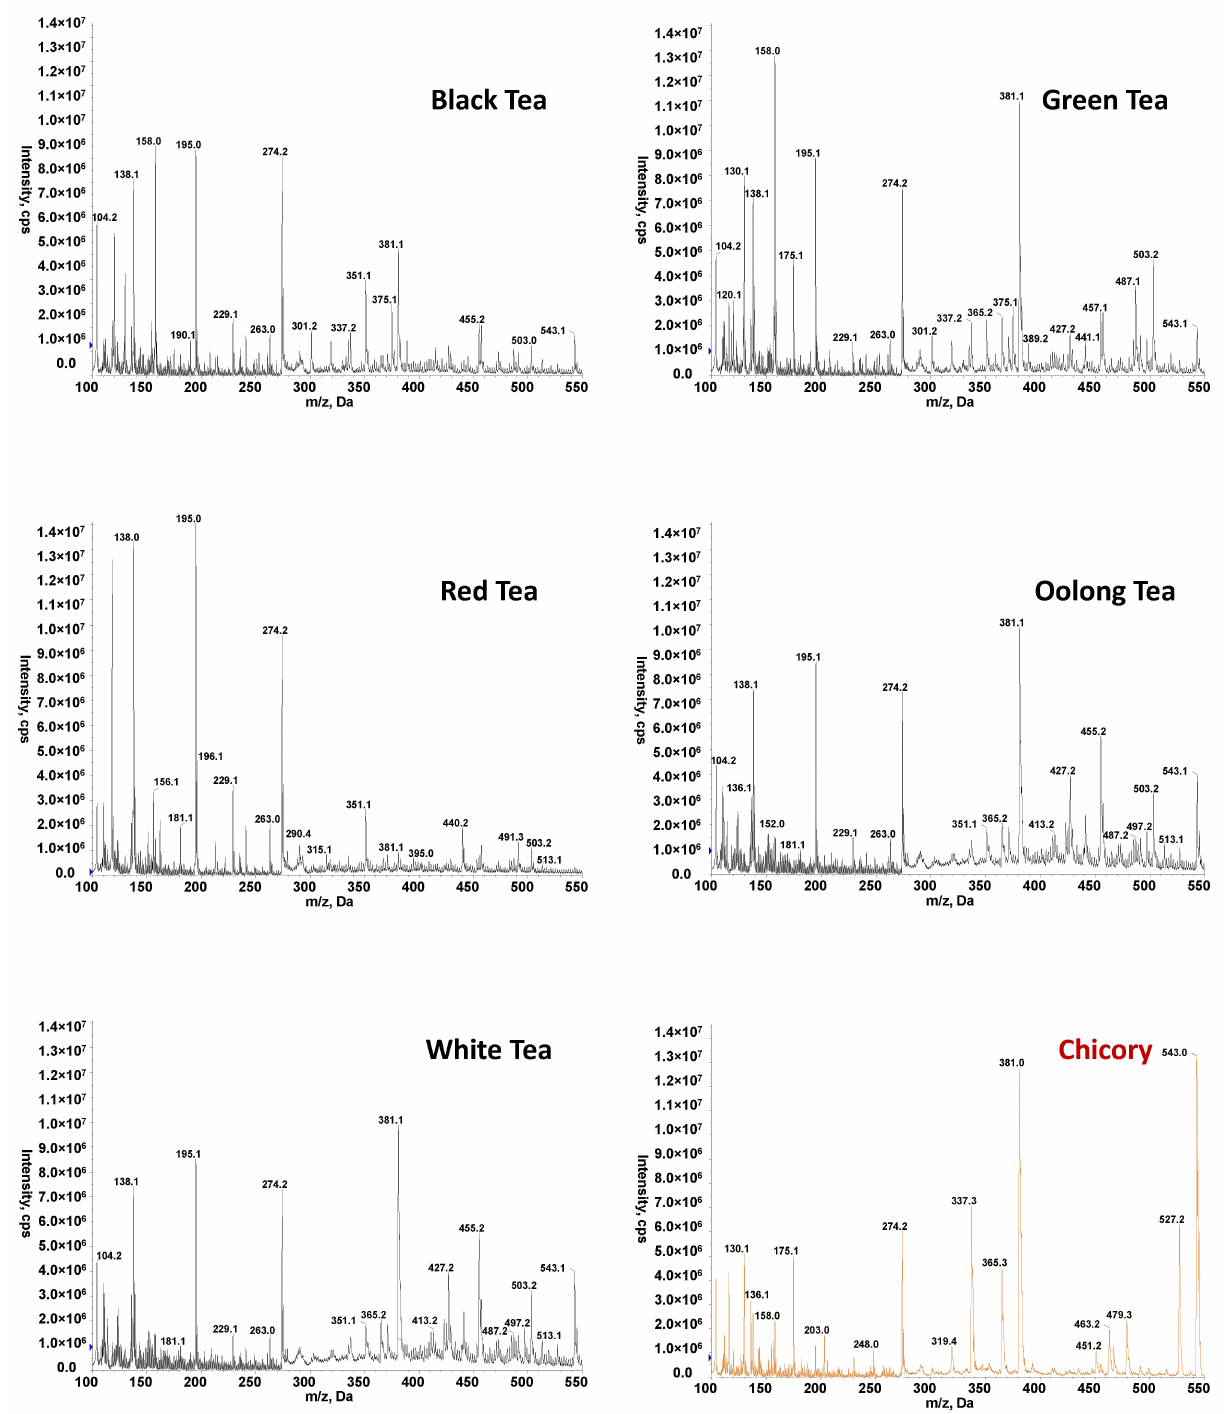
Figure 2. Non-targeted FIA-ESI(+)-MS fingerprints for selected tea and chicory